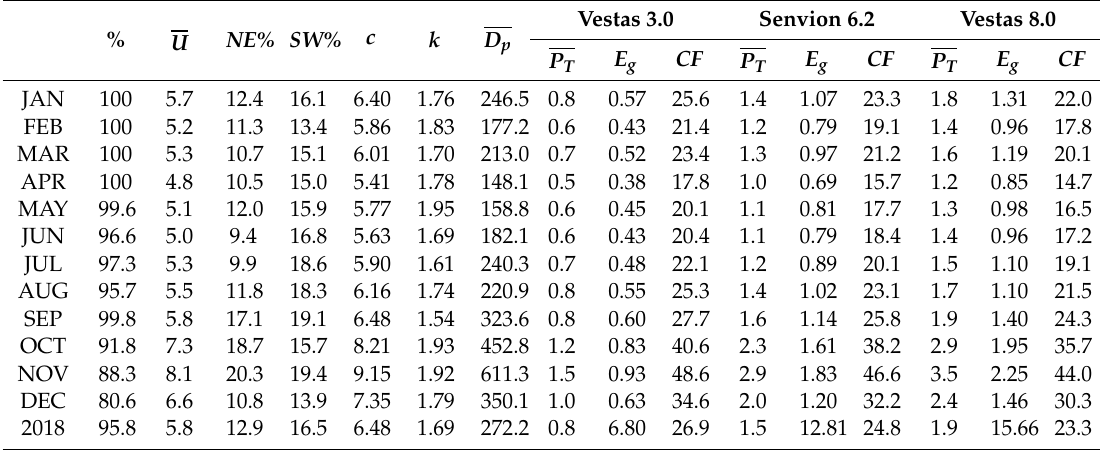
Table 4. Similar to Table 3, but referring to the year